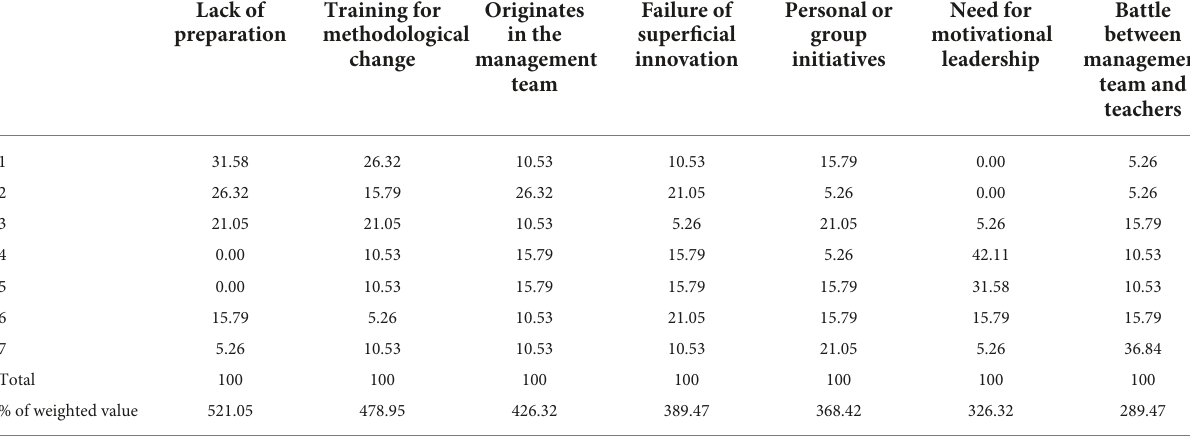
TABLE 9 Opinions on teacher participation in innovation processes, from highest to lowest priority.